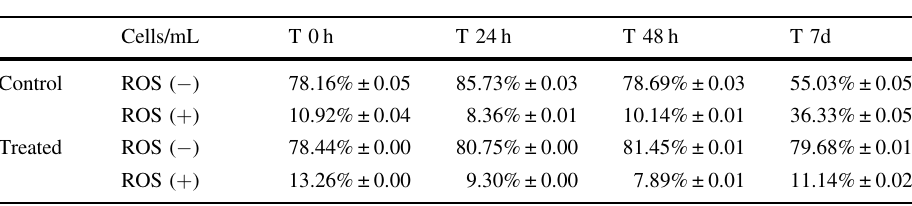
Table 1 Quanti fi cation of the % of eBMMSCs ROS ( + ) and ( −